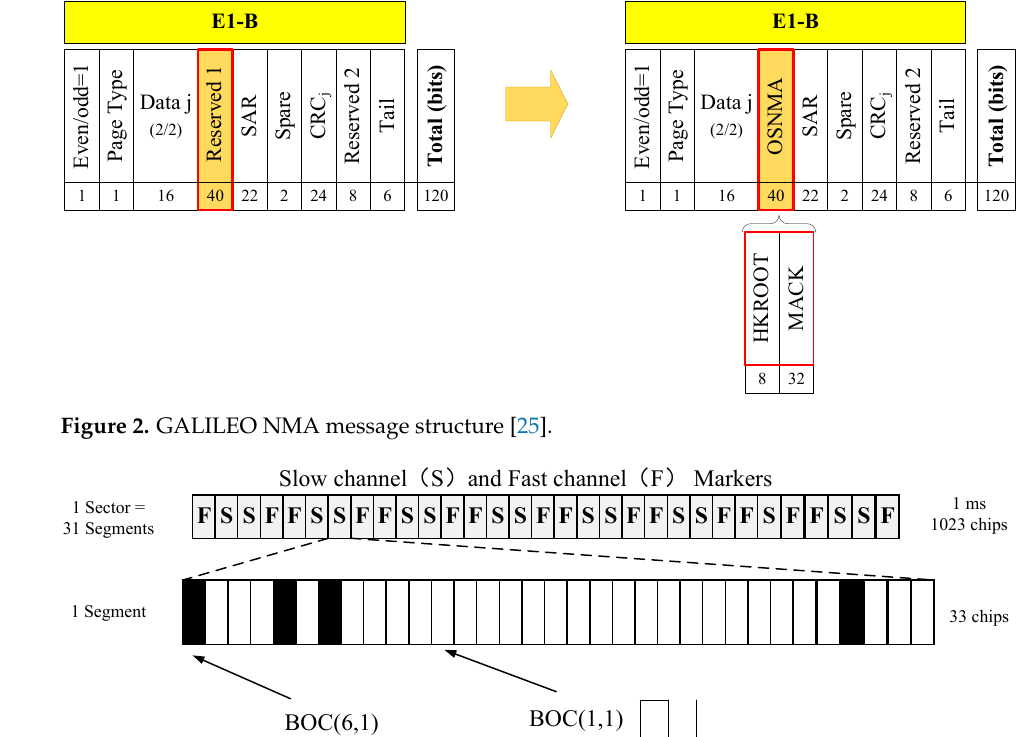
Figure 3. CHIMERA spreading code [26].